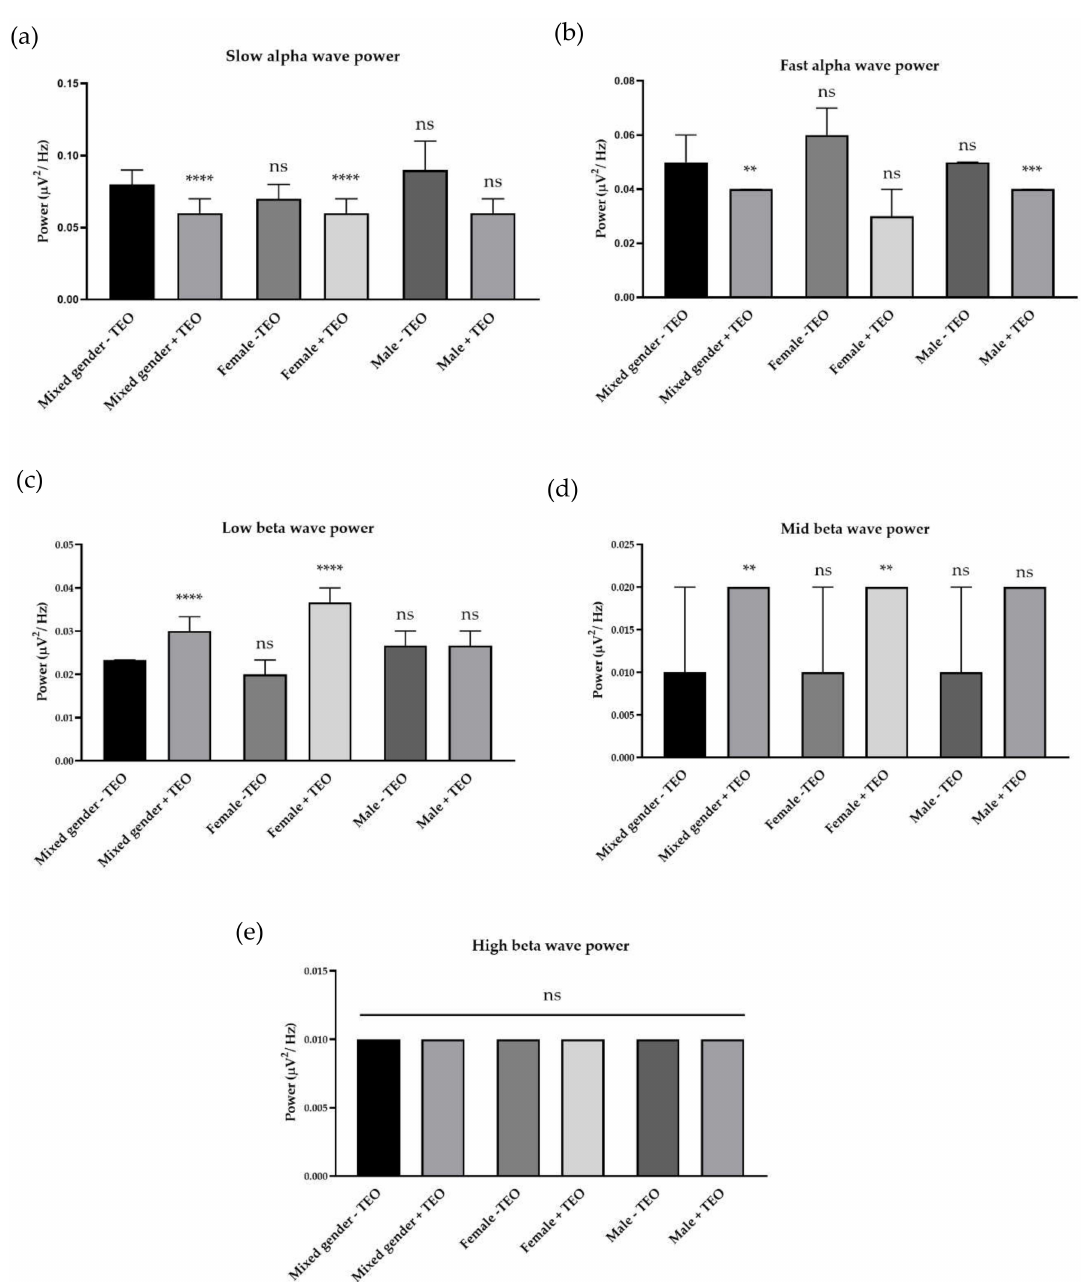
Figure 2. E ff ects of tangerine essential oil inhalation: ( a ) slow alpha (9 Hz); ( b ) fast alpha (12 Hz); ( c ) low beta (14 Hz); ( d ) mid beta (17 Hz); ( e ) high beta (25 Hz). p value: ns ≥ 0.05, ** < 0.01, *** < 0.001, **** <